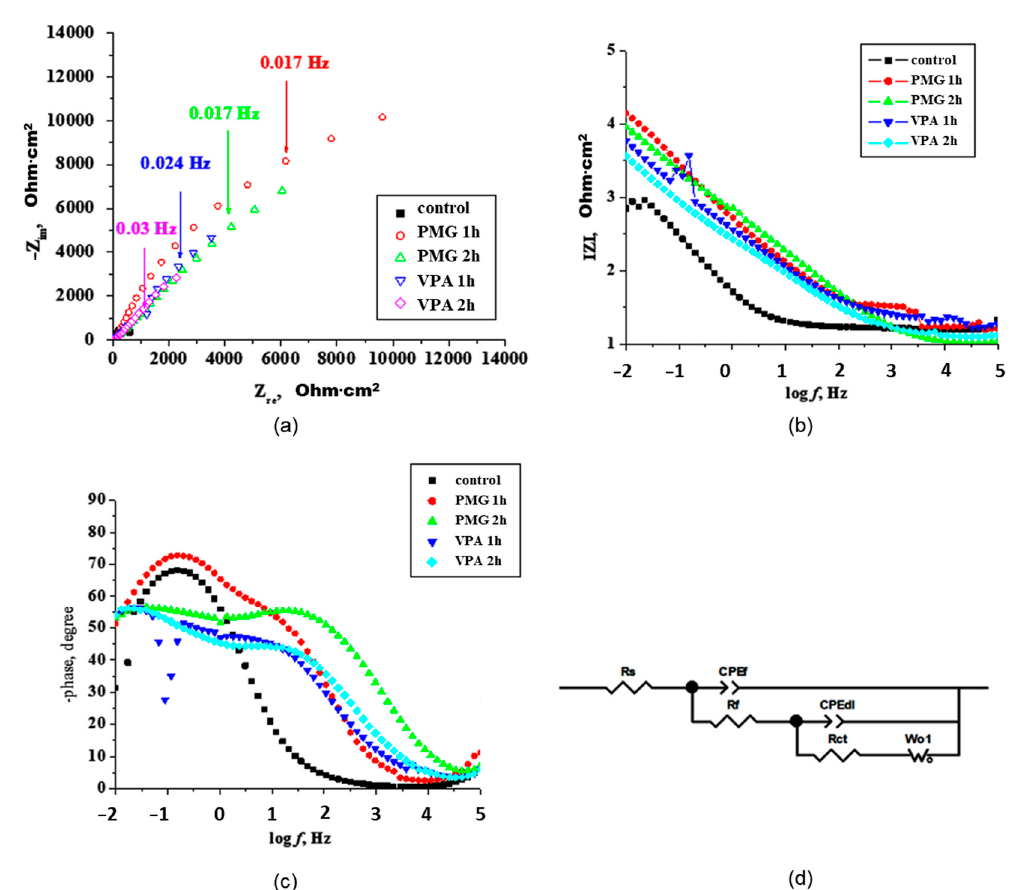
Figure 3. ( a ) Complex plane Nyquist plots, ( b ) Bode plots the logarithm of the impedance modulus |ZI, ( c ) phase angle as a function of the logarithm of the frequency f for iron immersed for 1 h in 3.5% NaCl solutions in the presence of inhibitors and ( d ) electrical equivalent